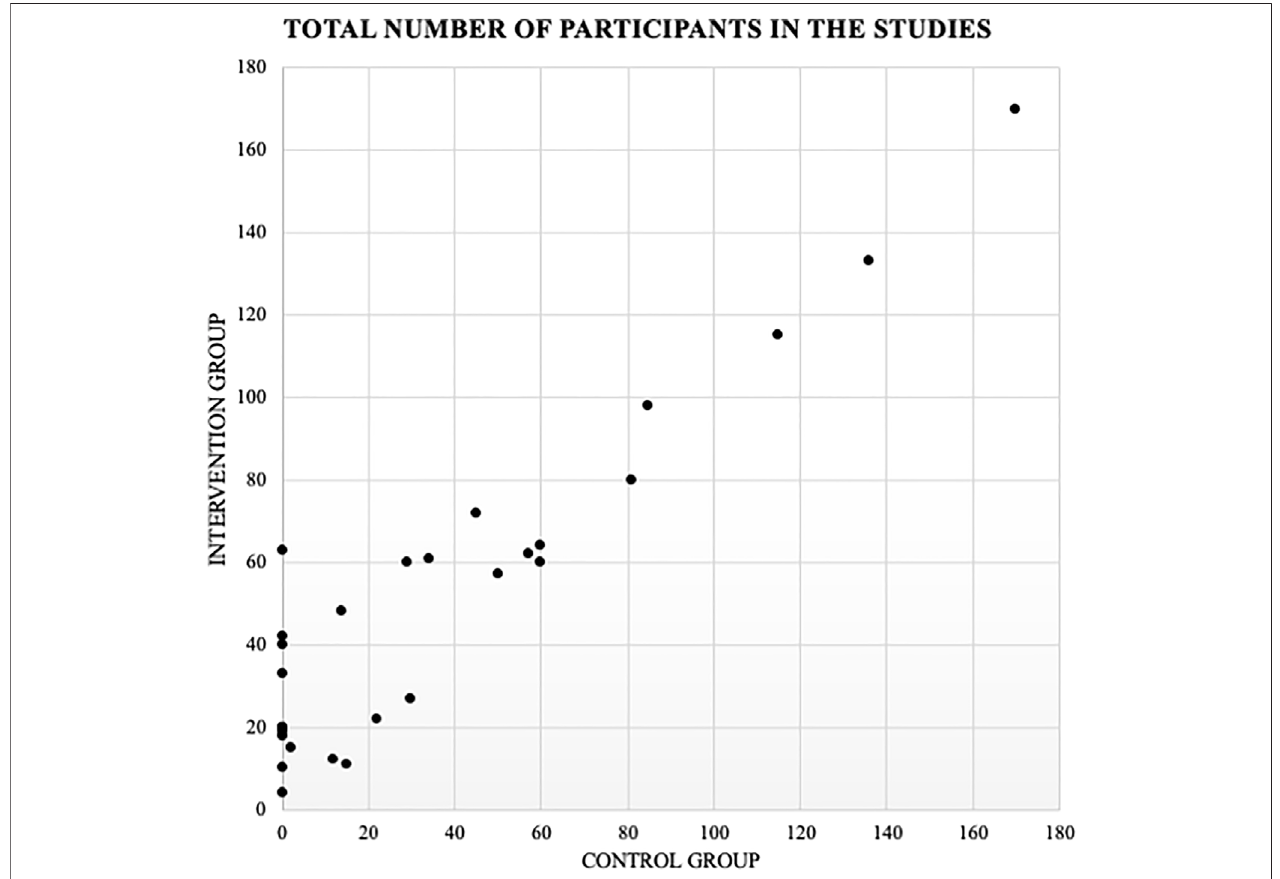
FIGURE 2 | Graphical representation of the distribution of the number of participants. Intervention (with technological intervention for the treatment of GDM) v/s Control (without technological intervention for the treatment of GDM).